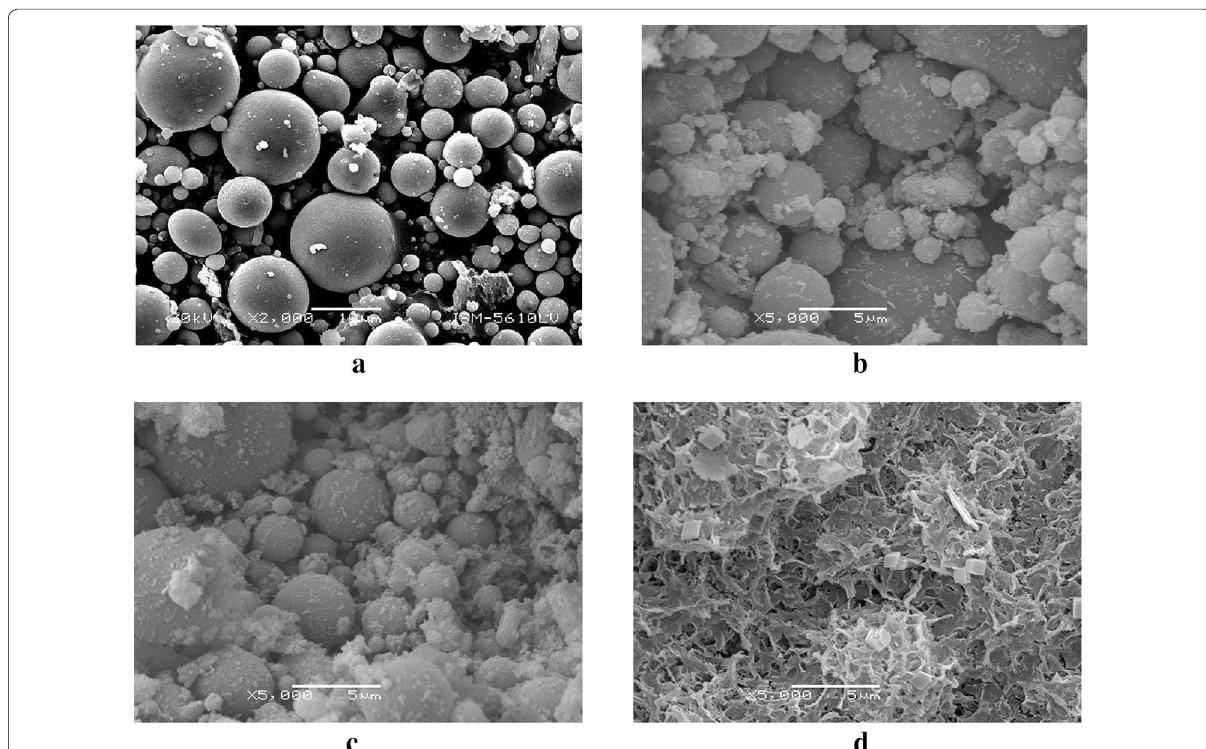
Fig. 8 Microstructure of FA30 cement mortar at different curing ages by SEM. a Fly ash, b curing age of 14 days, c curing age of 28 days, d curing age of 28